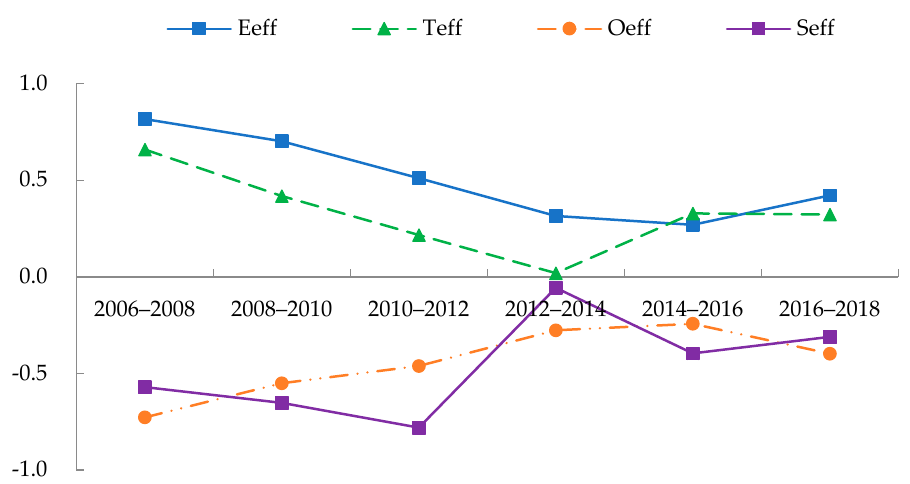
Figure 7. Driving e ff ects of EWP in China: 2006 − 2018. Figure 7. Driving effects of EWP in China: 2006 −